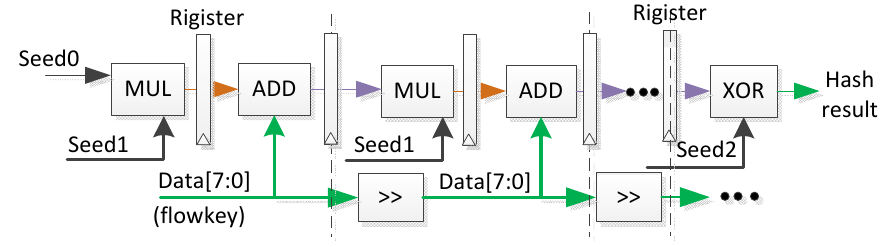
Figure 9. Architecture of a hash unit.